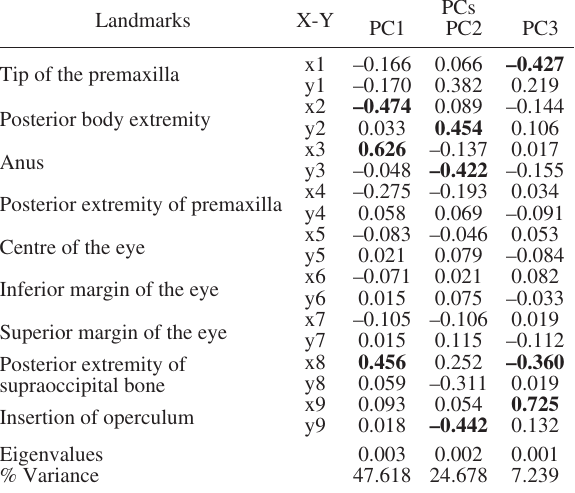
Table 2. – Principal Component Analysis. PC, principal component. The highlighted cells correspond to the extreme values (in magni- tude) of factor loadings for each PC, and indicate landmark coordi- nates that make a greater contribution to the larval shape variation.